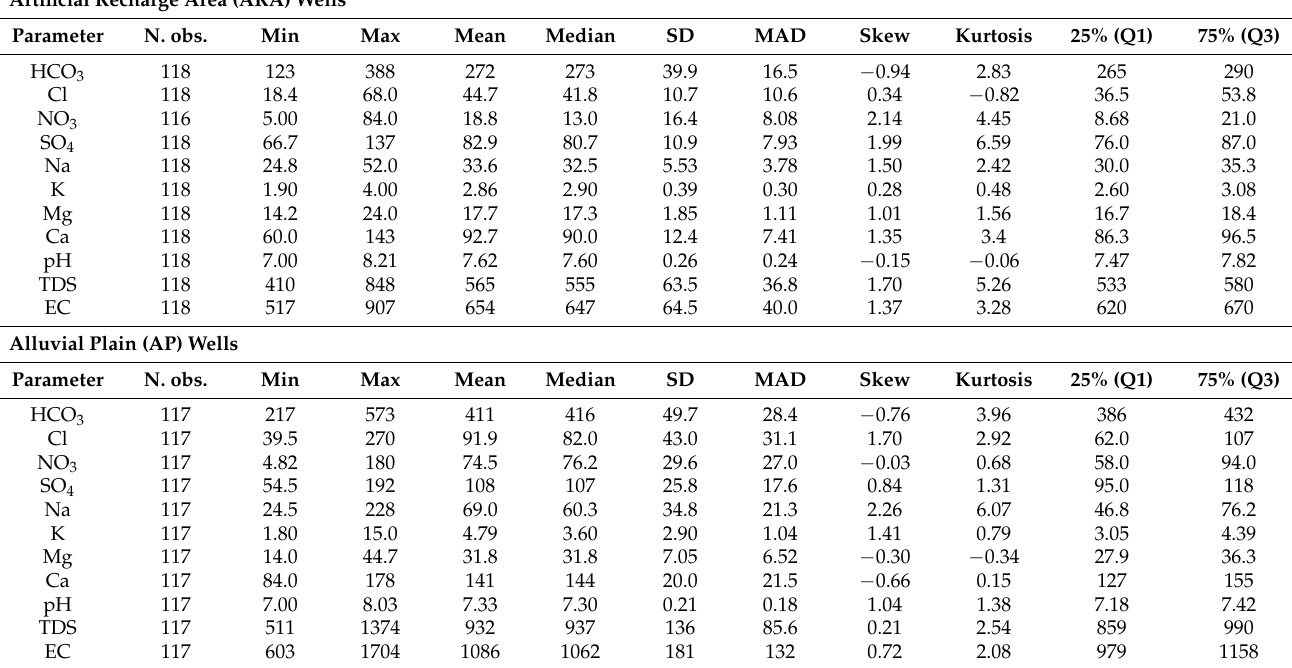
Table 2. Descriptive statistics related to the subset of complete and balanced analyses for ARA (upper panel) and AP (lower panel) monitored wells, respectively. N. Obs. = number of avail- able measurements; Min = minimum value; Max = maximum value; Mean = average value; Median = median value; SD = standard deviation; MAD = median absolute deviation; Skew = third standardized moment; Kurtosis = fourth standardize moment; 25% (Q1) = 1st quartile value; 75% (Q3) = 3rd quartile value. Data are expressed in mg/L and observations <DL were previously replaced with the value of the detection